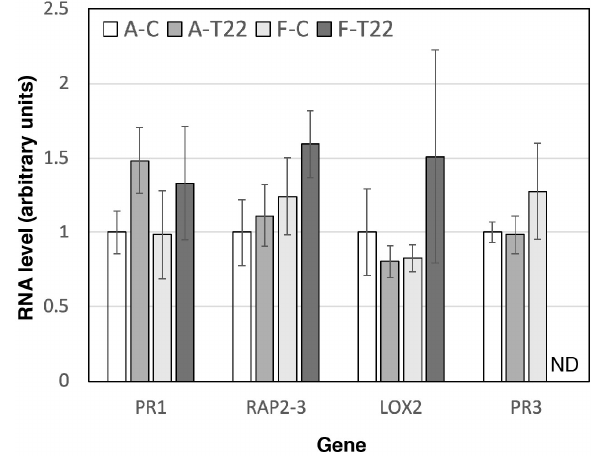
Figure 2. Gene responses to T22 treatment. Transcript levels in sand-grown roots of genotypes A (A-C, A-T22) and F (F-C, F-T22) are shown at 8 h after treatment with germinated T22 conidiospores (A- T22, F-T22) and water control (A-C, F-C). Data are presented as averages ± SE for three biological